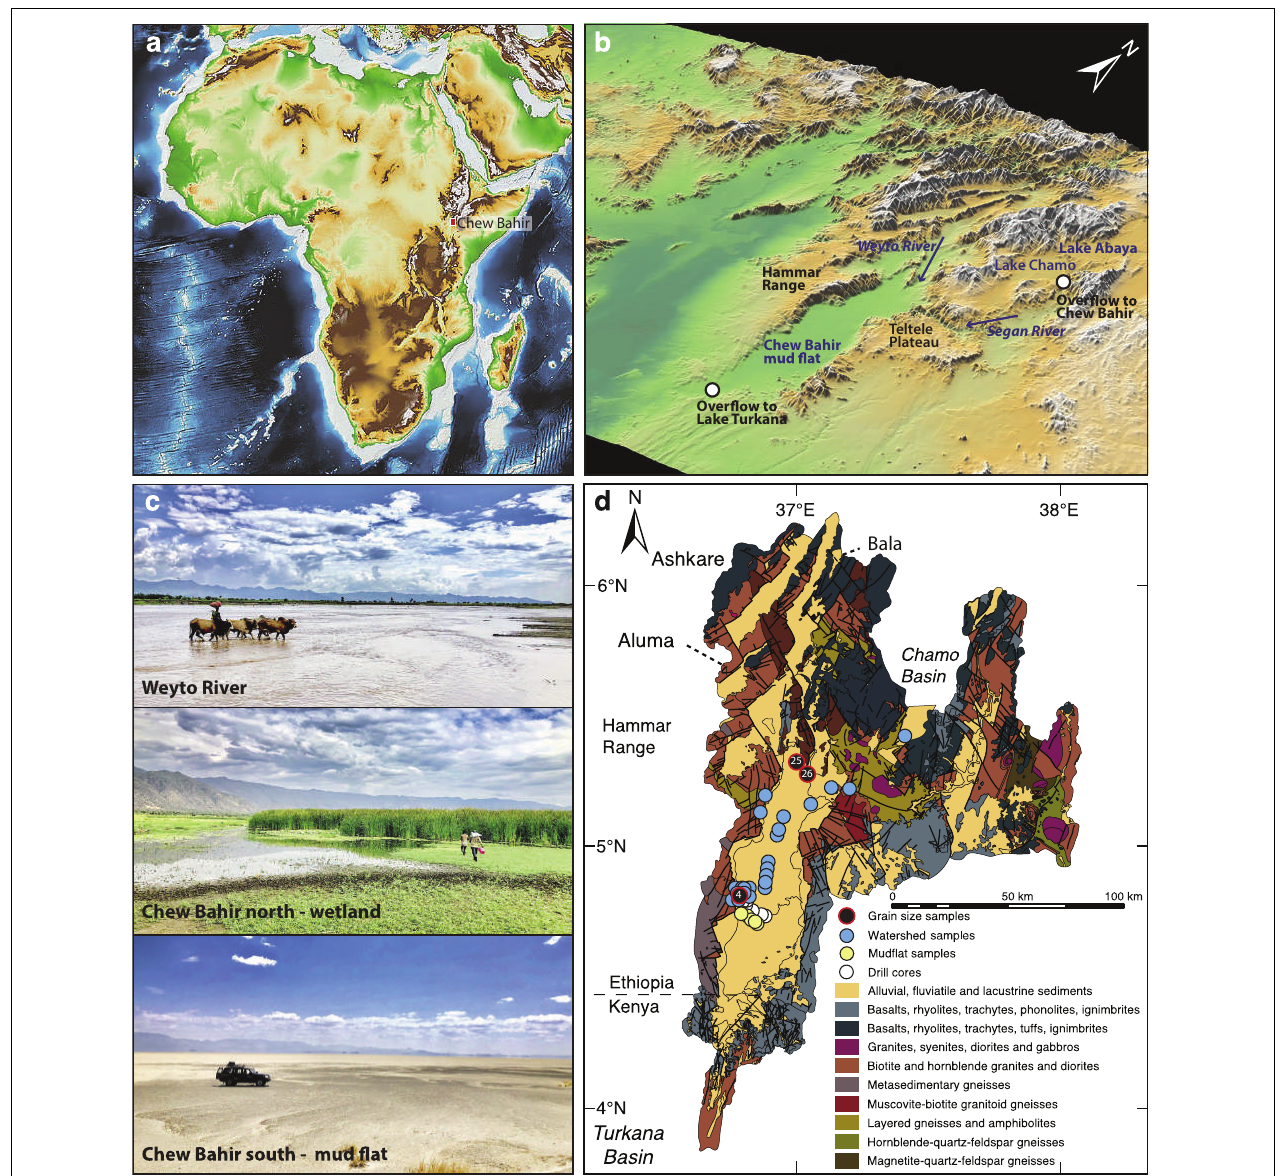
FIGURE 1 | Elevation map of (a) eastern Africa with (b) 3D, (c) field, and (d) geologic representation of the Chew Bahir basin. Filled blue and yellow-green circles in (d) show sampling locations for modern watershed (WS) and mudflat (MF) samples, respectively. Filled black circles in (d) show locations of samples collected from the Chew Bahir catchment for grain size